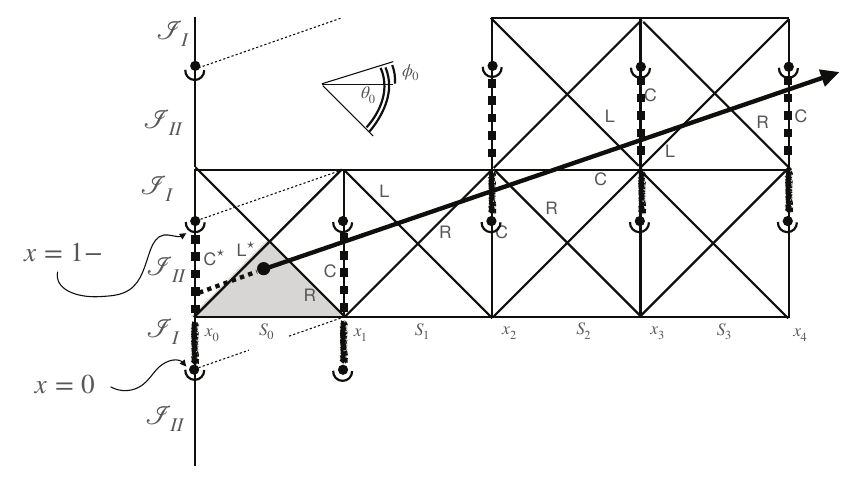
Figure 2: The relationship between the dynamics in a 45 ◦ : 45 ◦ : 90 ◦ billiards and irrational rotations. The grey triangle corresponds to the billiards in question. The white triangles are the images of the original billiards obtained via mirror reflections with respect to the wall that the particle hits. The subsequent fragment of the particle’s trajectory is reflected as well; as a result, the trajectory becomes a straight line traveling through a plane tiled by the copies of the original billiards. The large black circle corresponds to the initial position of the particle. The vertical dotted and “hand-drawn” lines correspond to two intervals in the related irrational rotation model. x phase space variable in the irrational rotations. See the text for the definition of the counter S . The time j counts the vertical C -lines crossed by the j